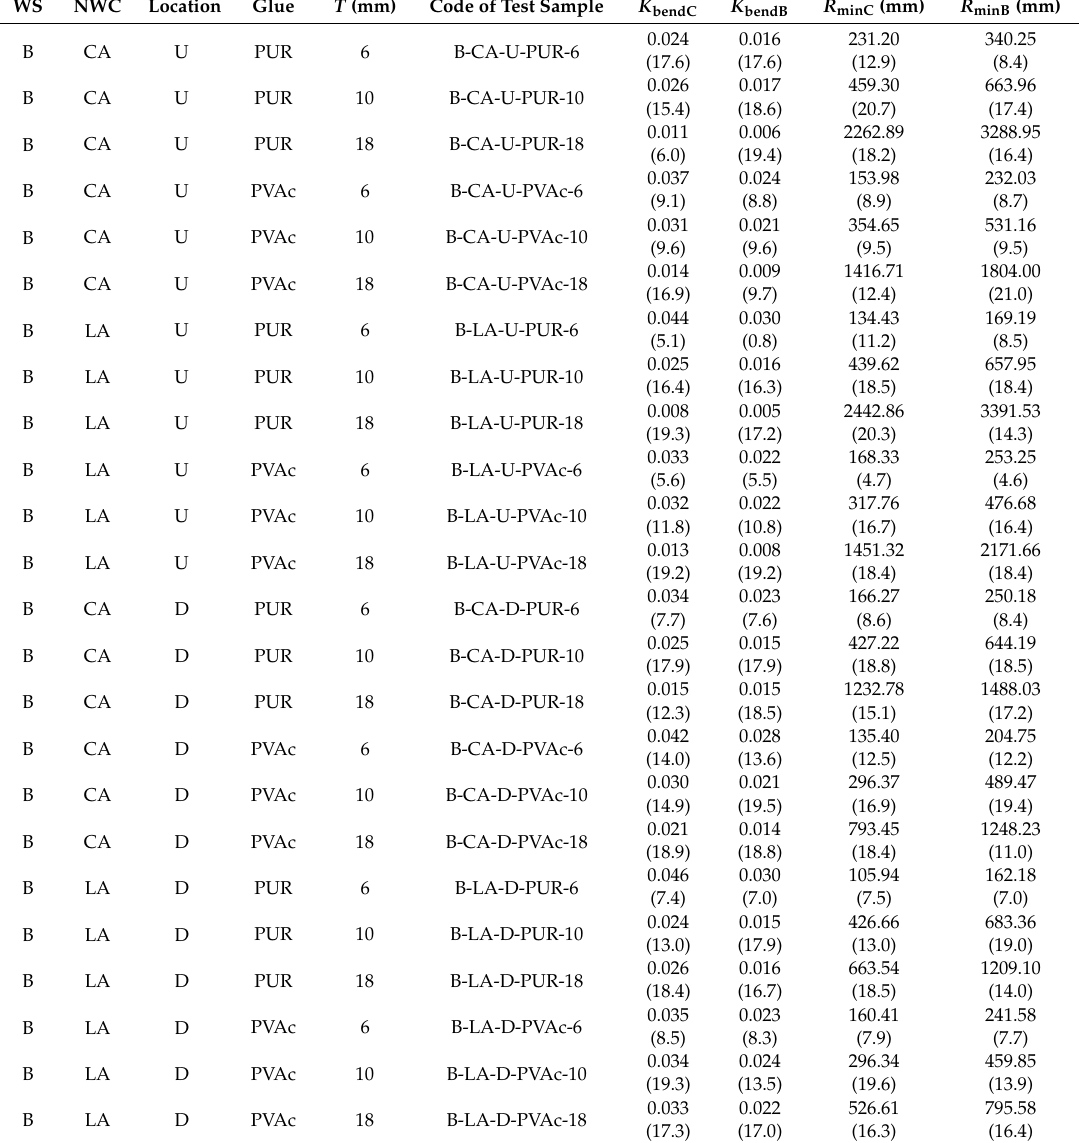
Table 2. Average values of bending characteristics and the coe ffi cients of variance of layered beech